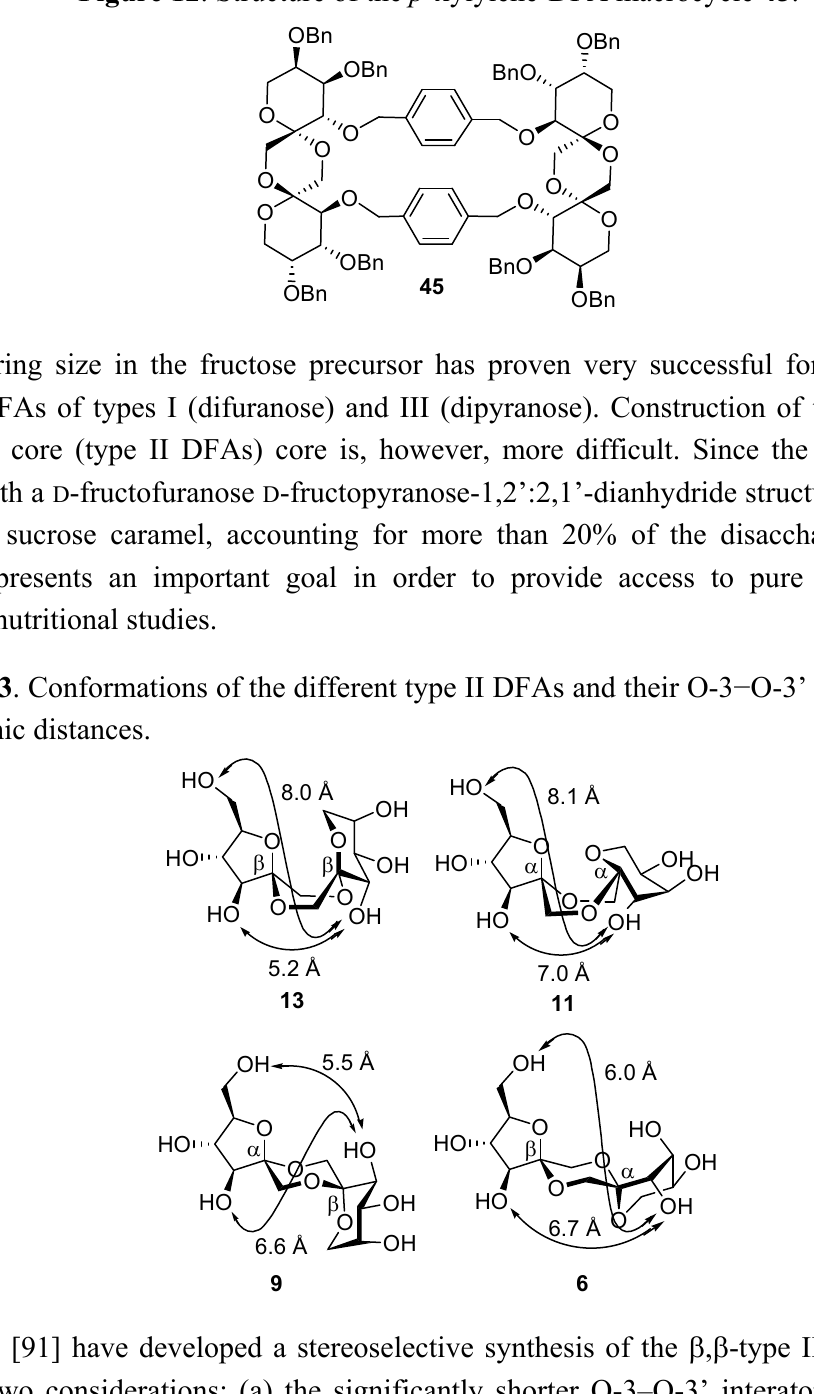
Figure 12 . Structure of the p -xylylene-DFA macrocycle 45 .